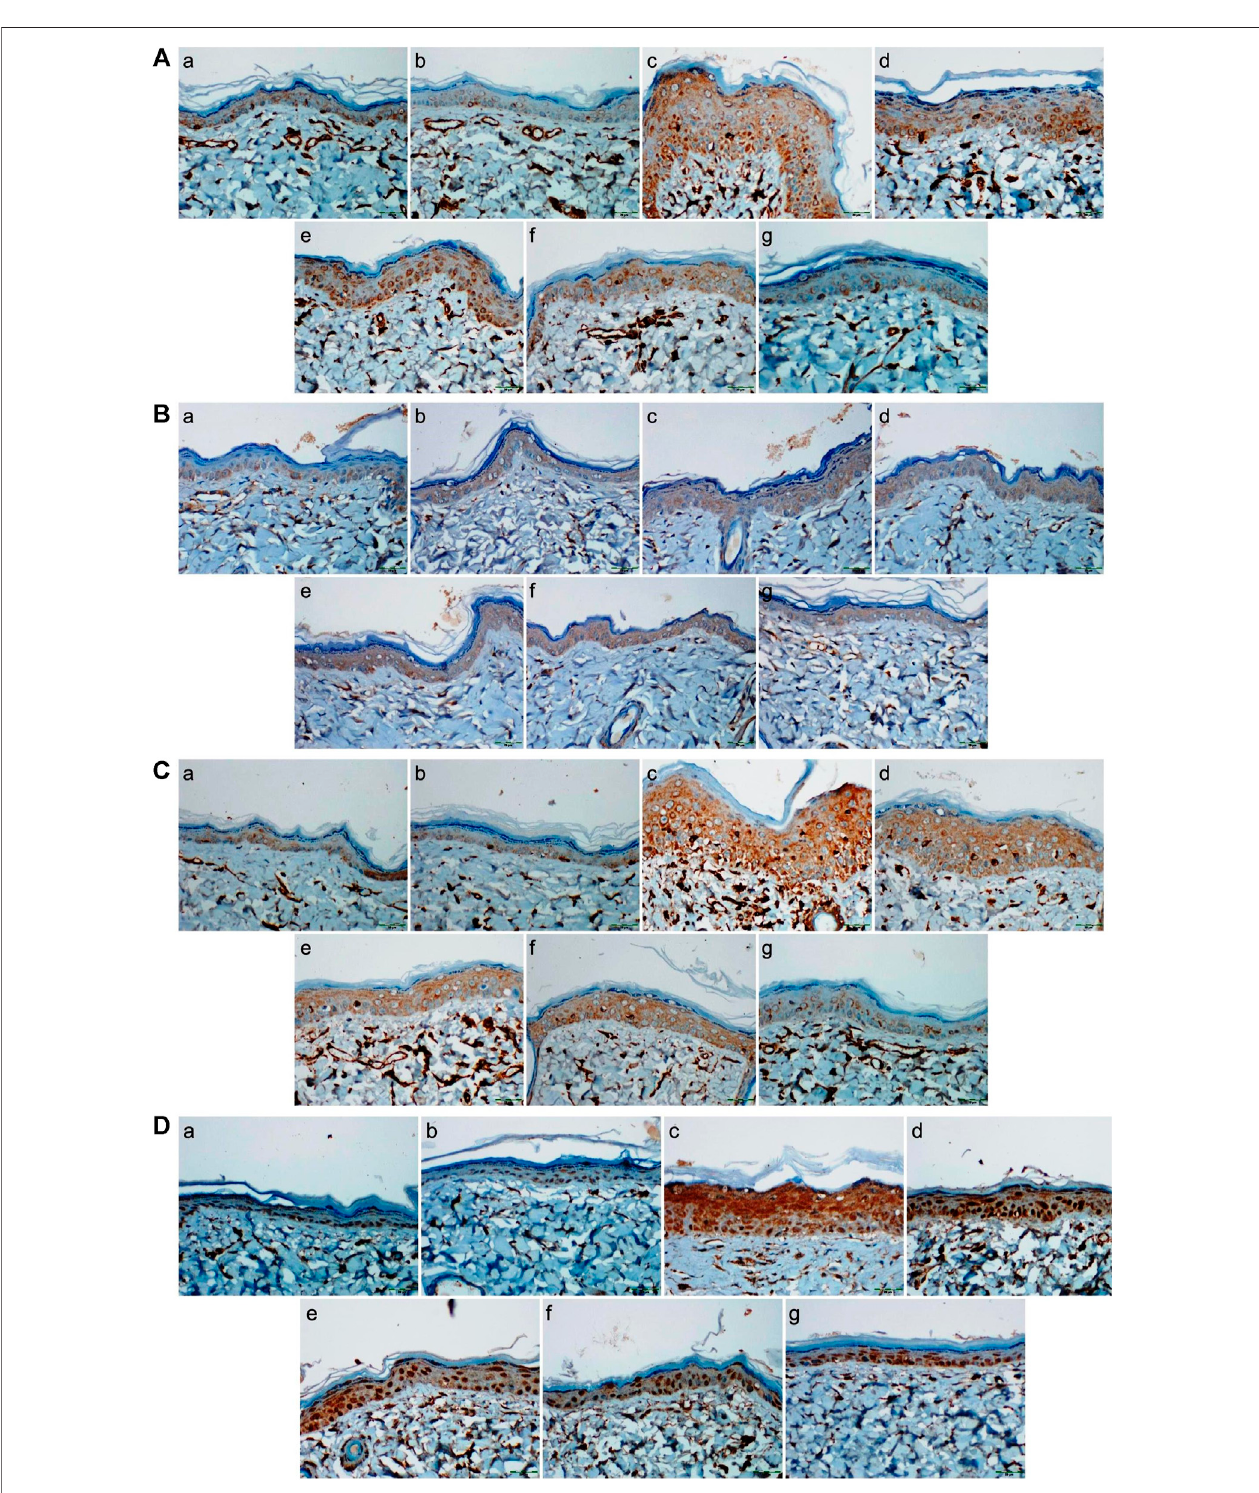
FIGURE 2 | Effect of inositol-stabilized arginine silicate complex (ASI) and magnesium biotinate (MgB changes of skin tissue stained with immunohistochemical stain for the mammalian target of rapamycin (p-mTOR; A ), matrix metalloproteinase-1 (MMP-1; B ), interleukin 6 (IL-6; C ), and cyclooxygenase (COX-2; D ) in rats with UVB-induced photoaging. For mTOR (E) , MMP-1 (F) , IL-6 (G) , and COX-2 (H) , the staining (0, 0%; 1, < 25%; 2, 25 – 50%; 3, 51 – 75%; and 4, > 75%) were scored. In immunohistochemical images, the groups are shown as a: NC, normal control; b: SC, shaved control; c: UVB; d : ASI + MgB-L; e: ASI + MgB-H; f: ASI + MgB-L + MgB-C; g: ASI + MgB-H + MgB-C. a – e : Values within the bars with different superscripts are signi fi cantly different (Kruskal-Wallis and Mann Whitney U test, p < 0.05).